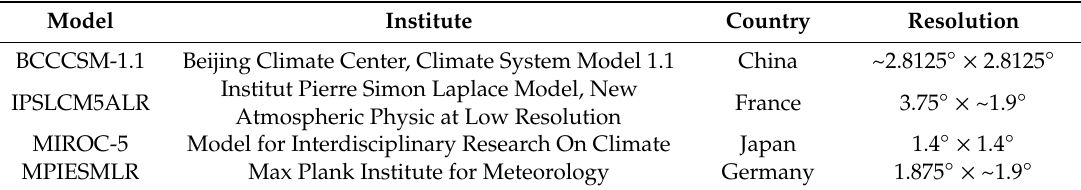
Figure 2. Climate change scenarios used in the paper. Table 1. Global Climate Models (GCMs), from the Climate Change Agriculture and Food Security (CCAFS, http://www.ccafs-climate.org) portal.